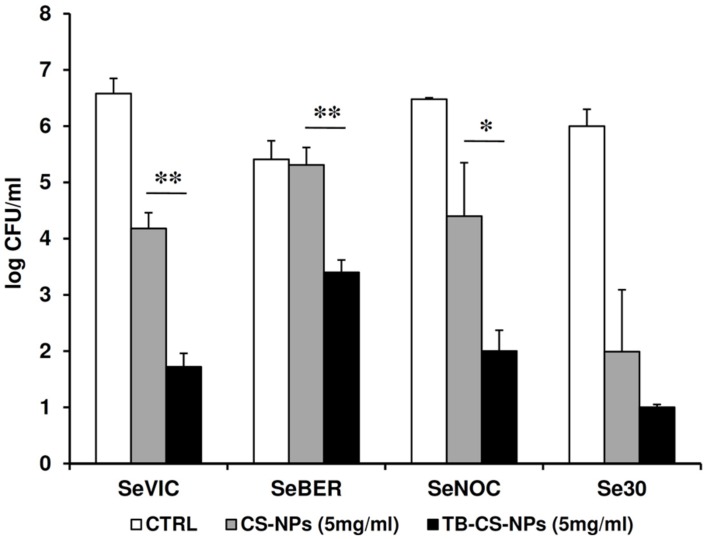
Antibacterial activity of TB-CS-NPs as compared to the plain nanocarrier against clinical isolates of S. epidermidis after 4 days of incubation. Bacterial cells were exposed for 4 days to plain CS-NPs or TB-CS-NPs. At the end of the exposure time aliquots of the cultures were serially diluted, plated on solid medium, and incubated at 37°C for 48 h before assessing the CFU count. Results are the mean values ± SEM of two independent experiments performed in duplicate. CTRL, control bacteria incubated in the assay medium only. ∗p < 0.05; ∗∗p < 0.01; as compared to TB-CS-NPs, Student’s t-test.